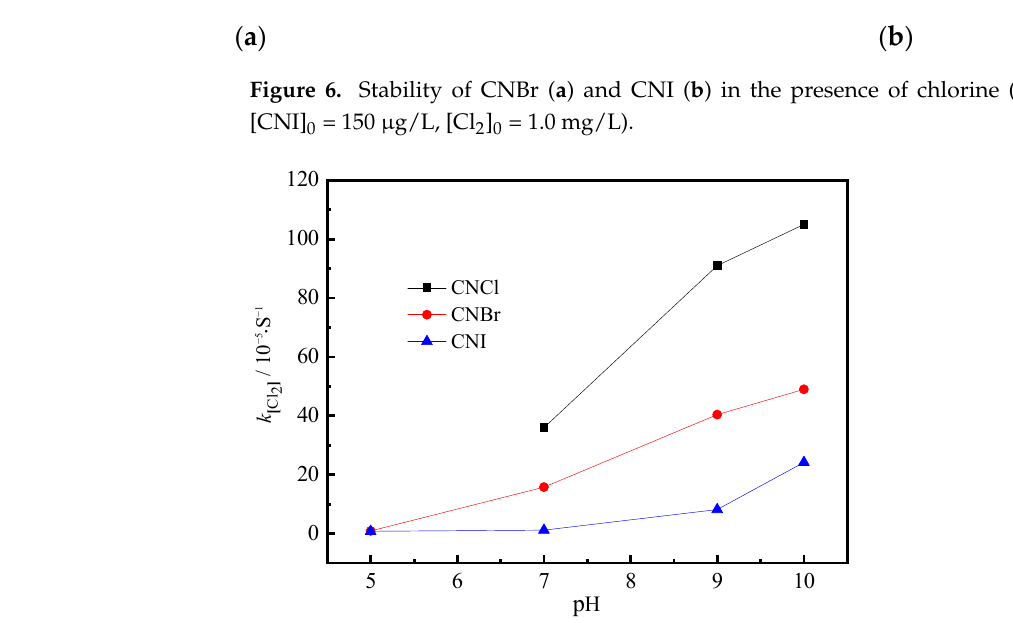
Figure 7. Effect of pH on the stability of CNXs.